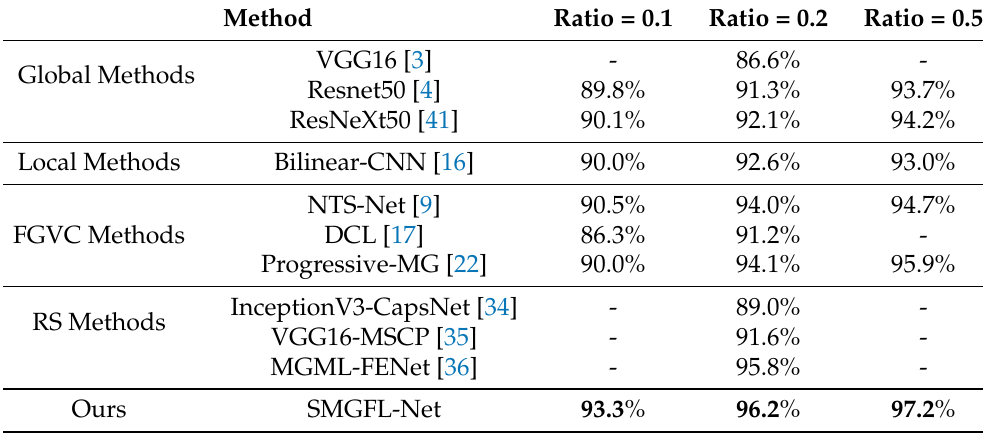
Table 6. Comparative results on